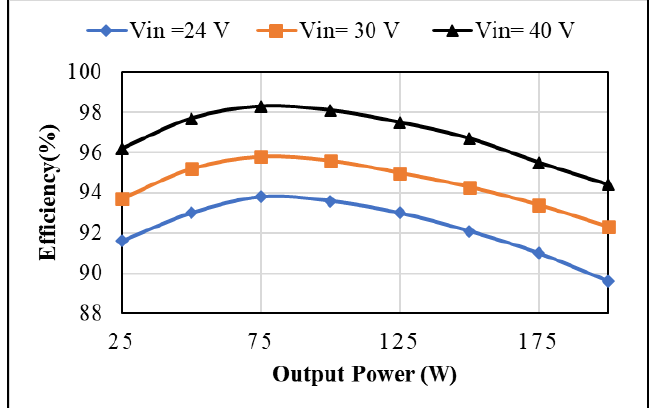
Figure 11. Efficiency of converter at different input voltages.